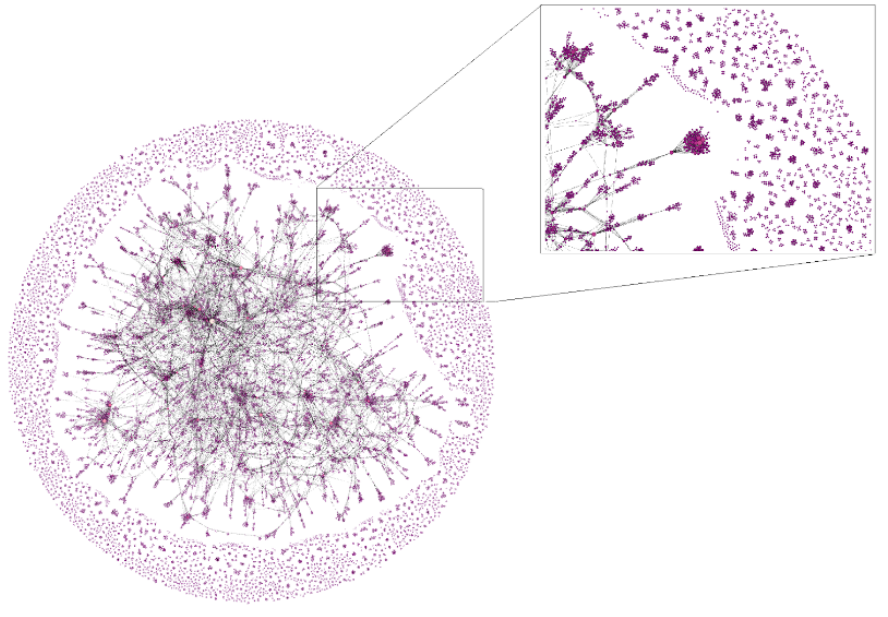
Figure 4. Collaboration network of researchers in power quality.